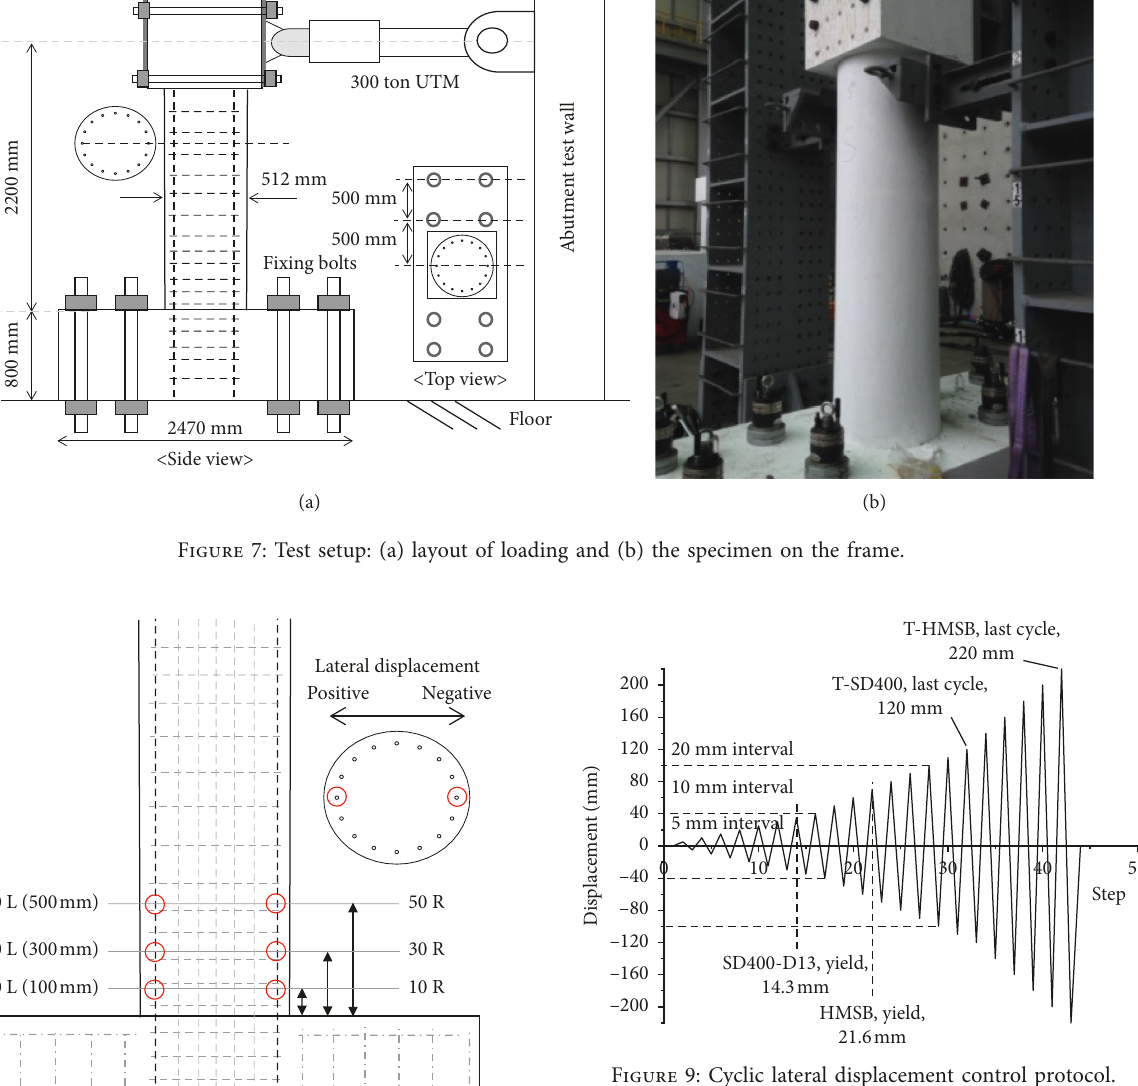
Figure 9: Cyclic lateral displacement control